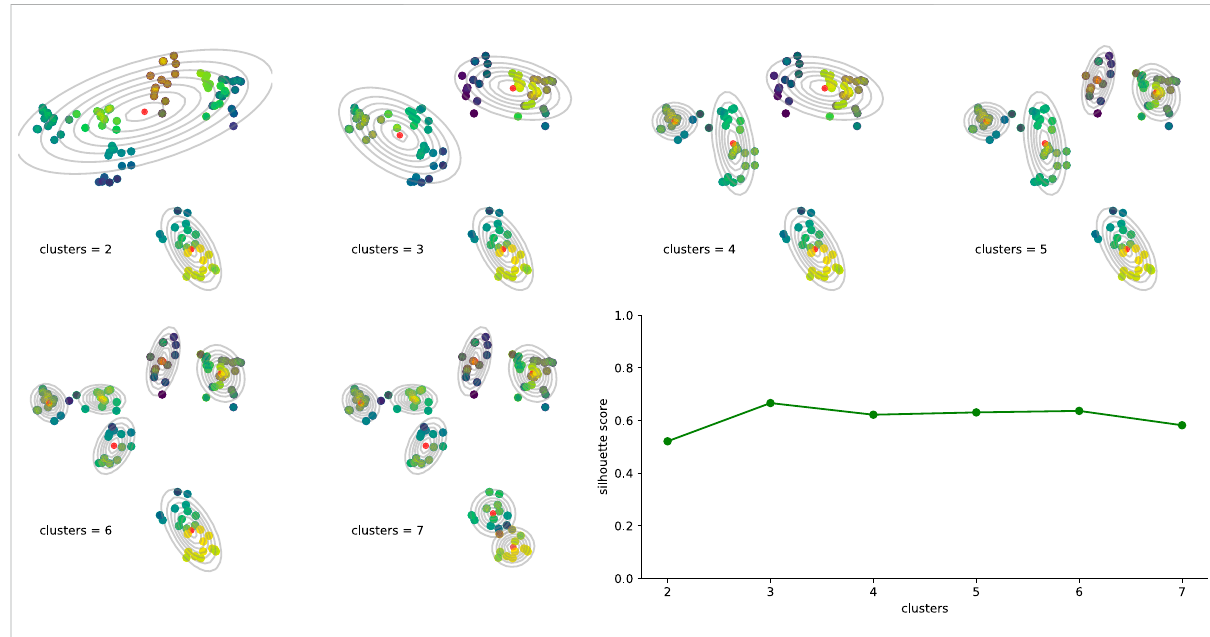
FIGURE 2 A fake dataset separated into two through seven clusters. The color of each data point indicates its silhouette number. The orientation of each cluster isindicated bycontourscomputedfrom thecovarianceproperties ofthat cluster, indicating thecoverageofthedata pointsin theparameter space. The optimal number of clusters is found using the plot at the lower right that shows the silhouette score versus the number of clusters; the number of clusters with the largest silhouette score is the optimal choice. See Figure 9 for the 3D version using real